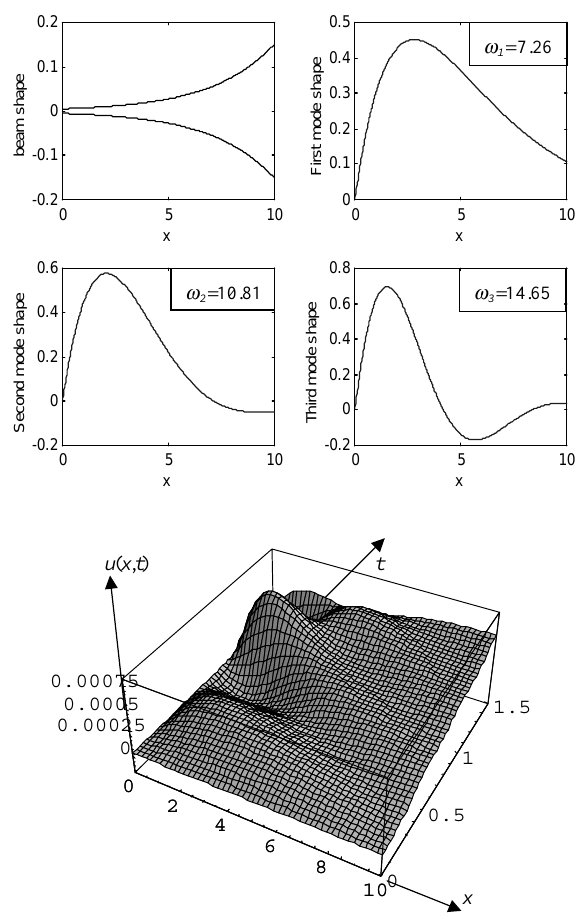
Fig. 4. Shape, first three eigenfunctions and time response of an aluminum fixed-free